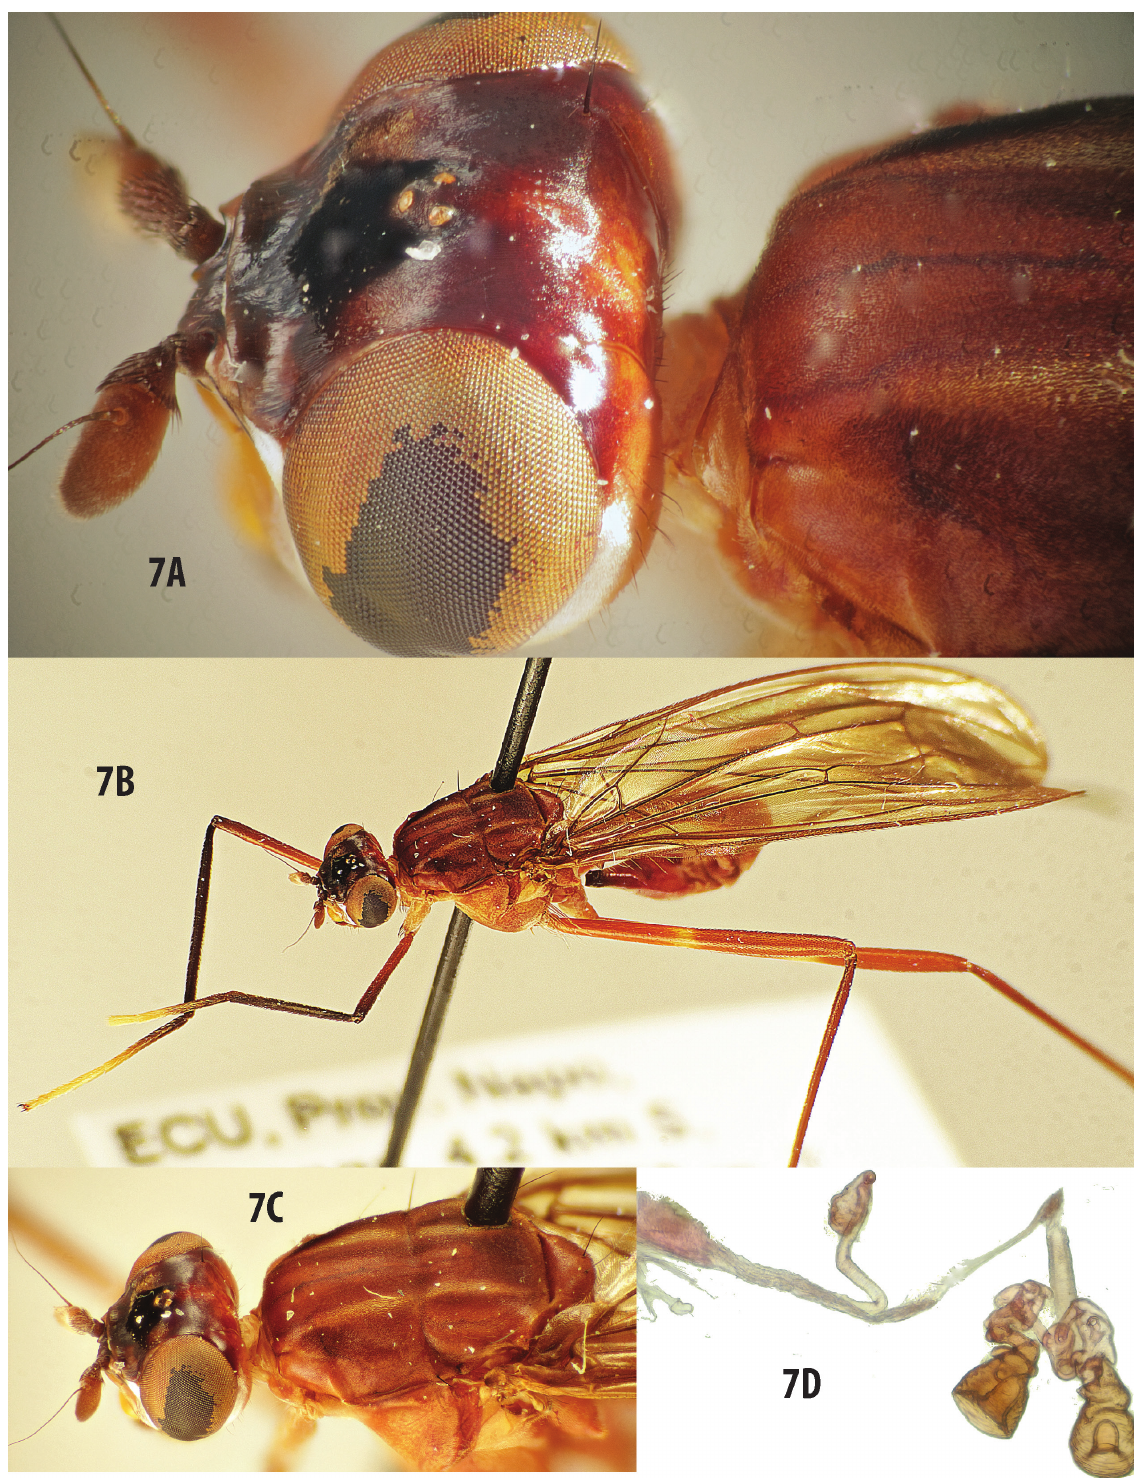
Fig. 7. Mesoconius cosanga sp. nov. , holotype, ♀, QCAZ. A . Head and notum. B . Habitus. C . Head and thorax. D . Spermatheca and associated